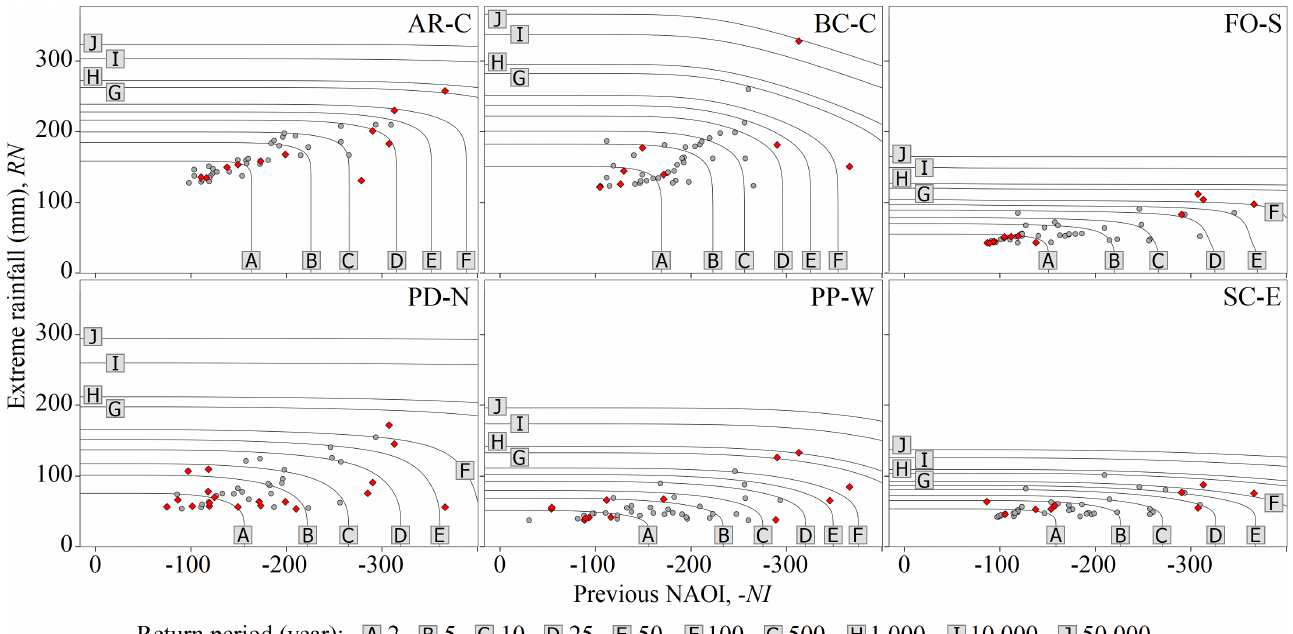
Figure 6. Contour lines of the joint return periods T NI a ndRN of the 45 bivariate events in each rain gauge. The letters, from A to J, stand for the different return periods between 2 and 50,000 years. The events occurring from 1967/1968 to 1999/2000 are depicted by grey bullets, and those from 2000/2001 and 2016/2017 by red